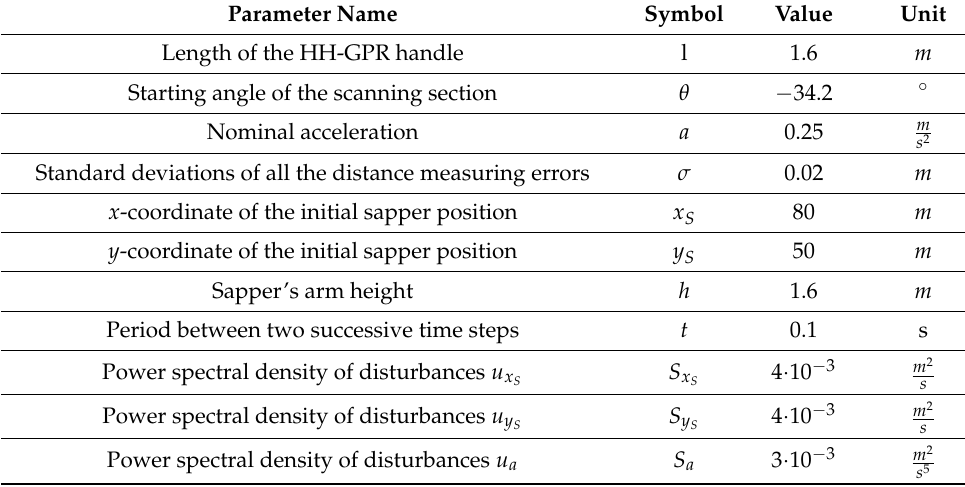
Table 3. Parameters used in dynamics and observation models during